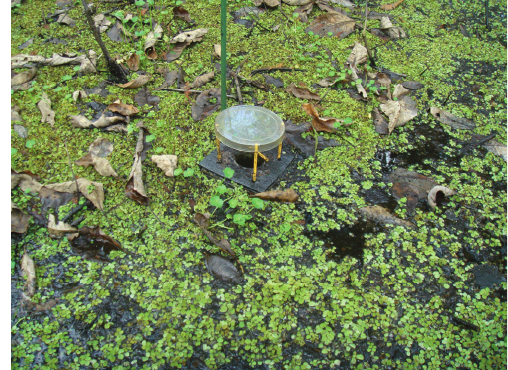
Figure 5: Floating pitfall trap shown floating on surface of water in cypress-tupelo-blackgum freshwater